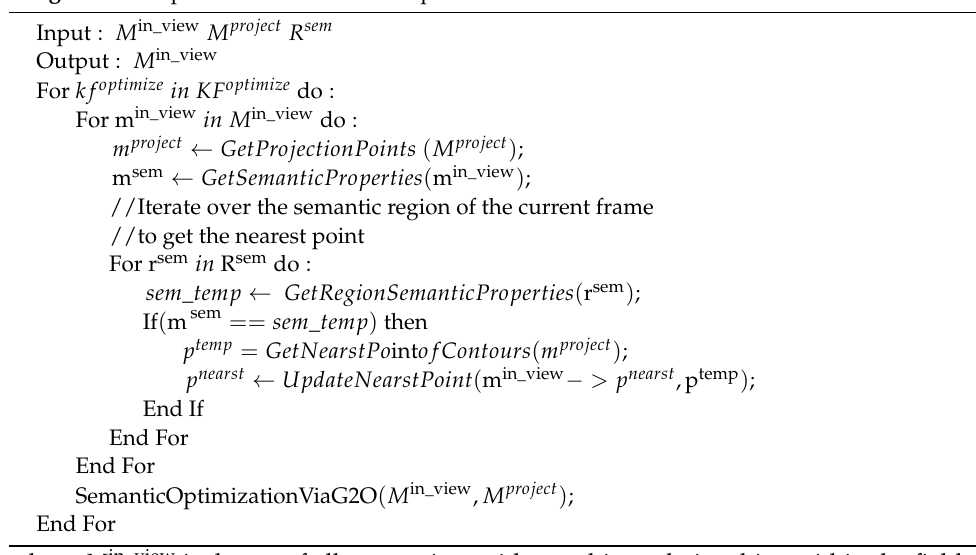
Algorithm 2 Update Nearst Point of Map